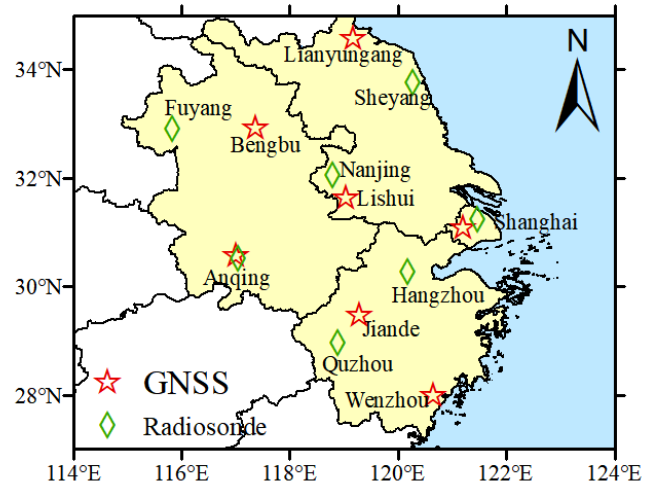
Figure 1. Distribution map of GNSS and radiosonde stations in the Yangtze River Delta region.